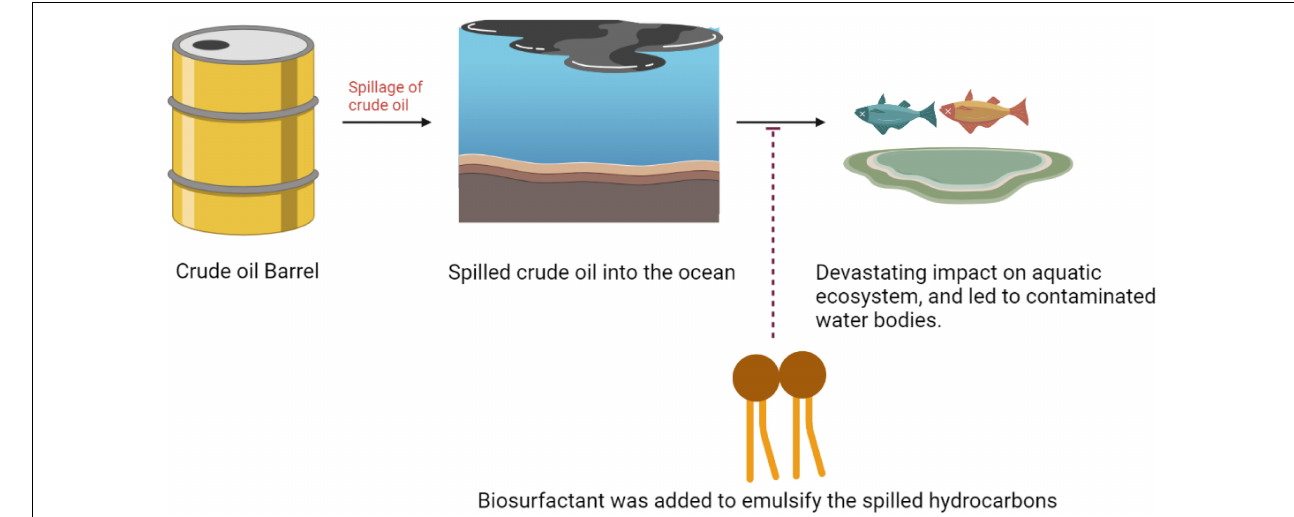
FIGURE 4 | Adverse effects of oil spilling and solution to mitigate such